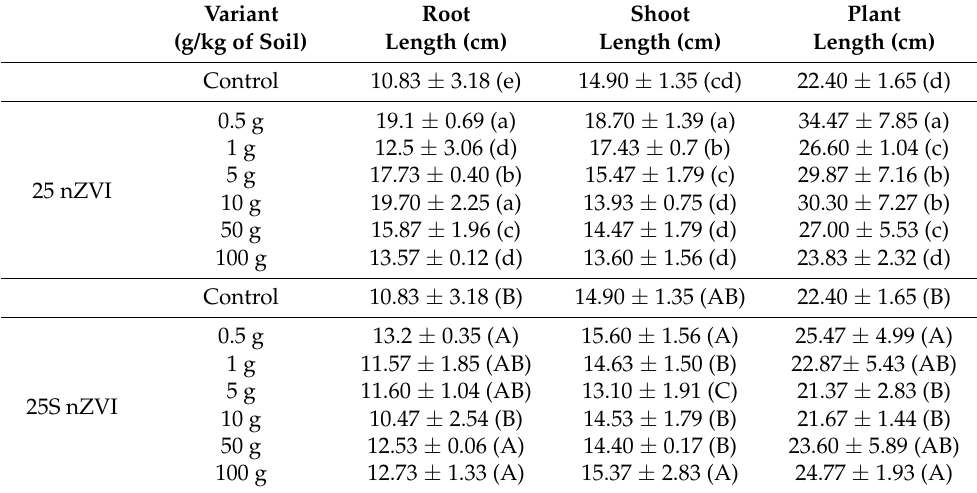
Table 3. Plant biometric parameters—length of root, shoot and whole